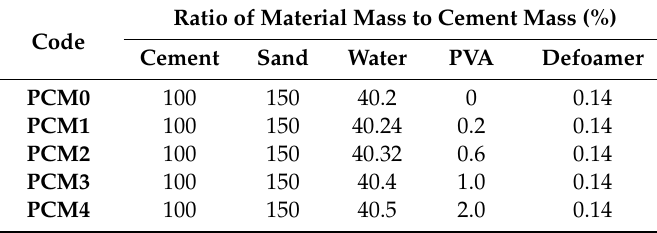
Table 4. Mix proportions of cement